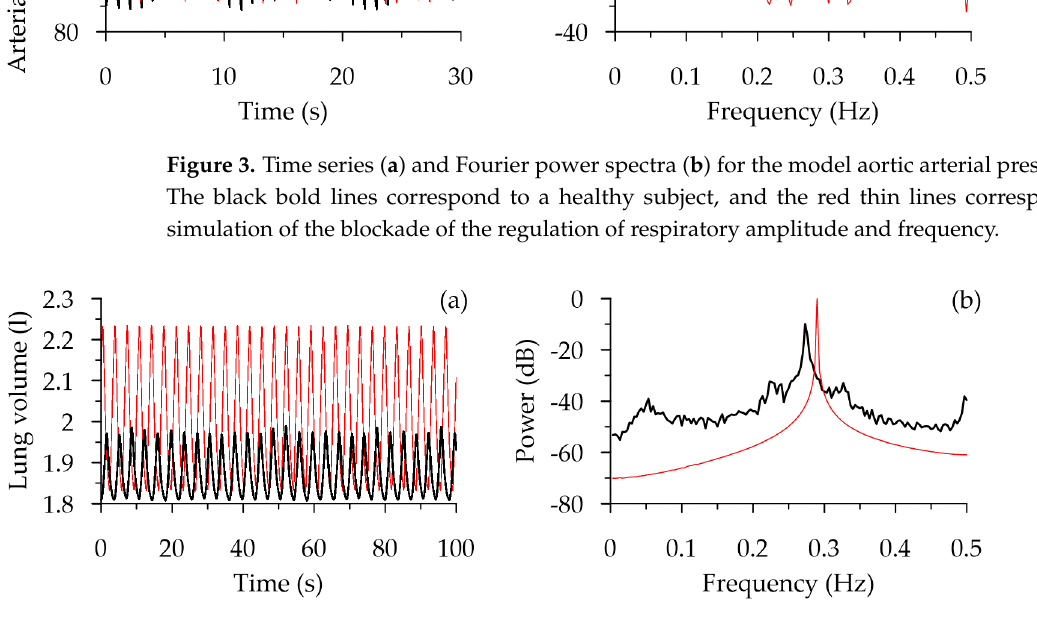
Figure 4. Time series ( a ) and Fourier power spectra ( b ) for the model signals of lung volume. The black bold lines correspond to a healthy subject, and the red thin lines correspond to the simulation of the blockade of the regulation of respiratory amplitude and frequency. Table 3. Spectral and statistical indices and complexity measures estimated from the model data.